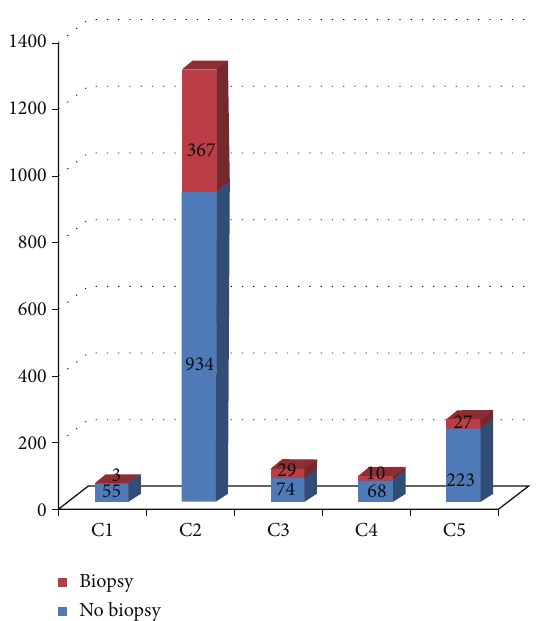
Figure 3: Cytology cases with follow-up